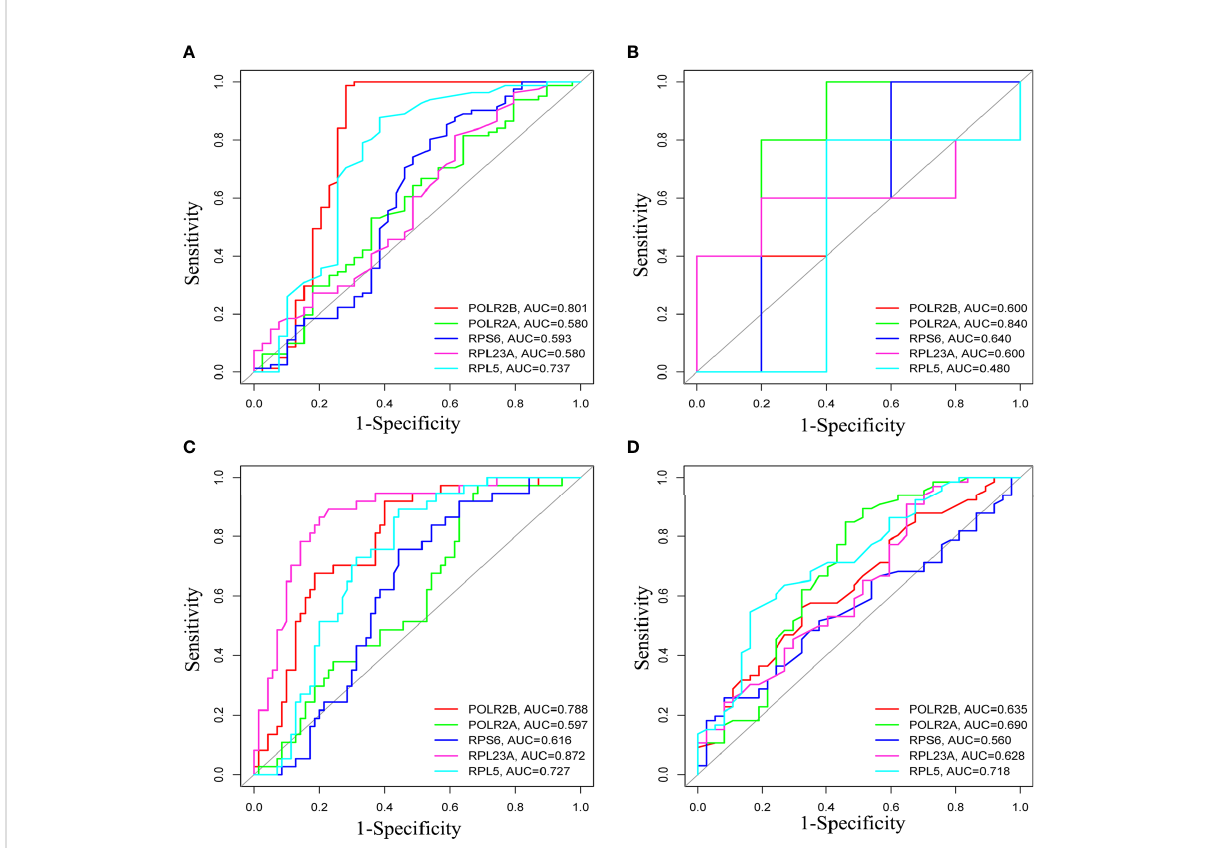
FIGURE 10 ROCcurve analysis to assess the diagnostic value of hub genes in differentiating HBV-HCC or HCV-HCC from liver tissues. (A, B) were HBV- HCC and HCV-HCC, respectively, in the internal data set, (C, D) were HBV-HCC and HCV-HCC, respectively, in the external veri fi cation